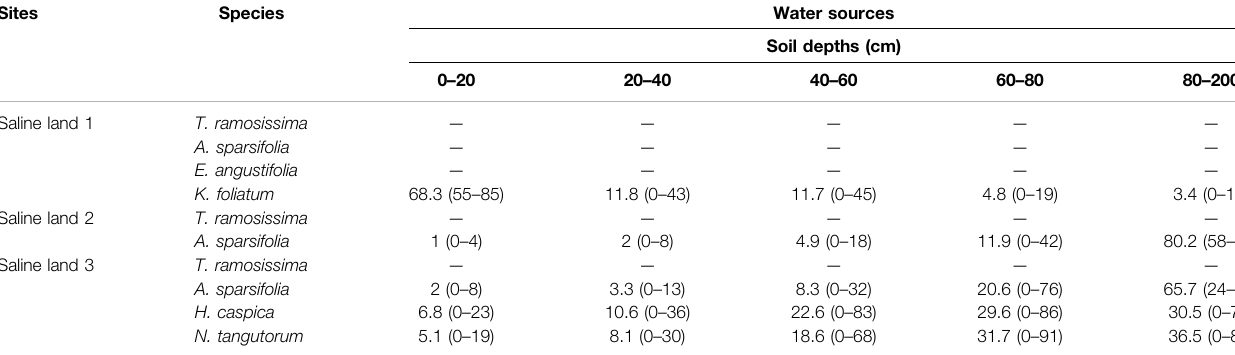
TABLE 3 | Properties of feasible water sources (%) for desert plants in the three saline lands [mean (min-max)].